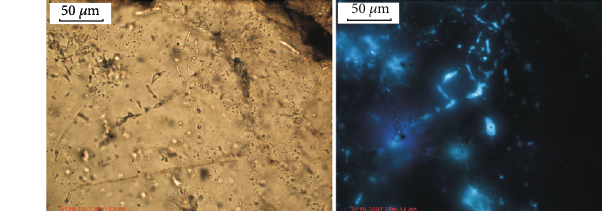
(b) Blue fl uorescent gas-liquid hydrocarbon inclusion (condensate) along the micro fracture group cutting through the quartz particle, 3395.9m, Sangonghe Formation, well Ke19; the left is under the plane-polarized light, and the right is under the UV-light